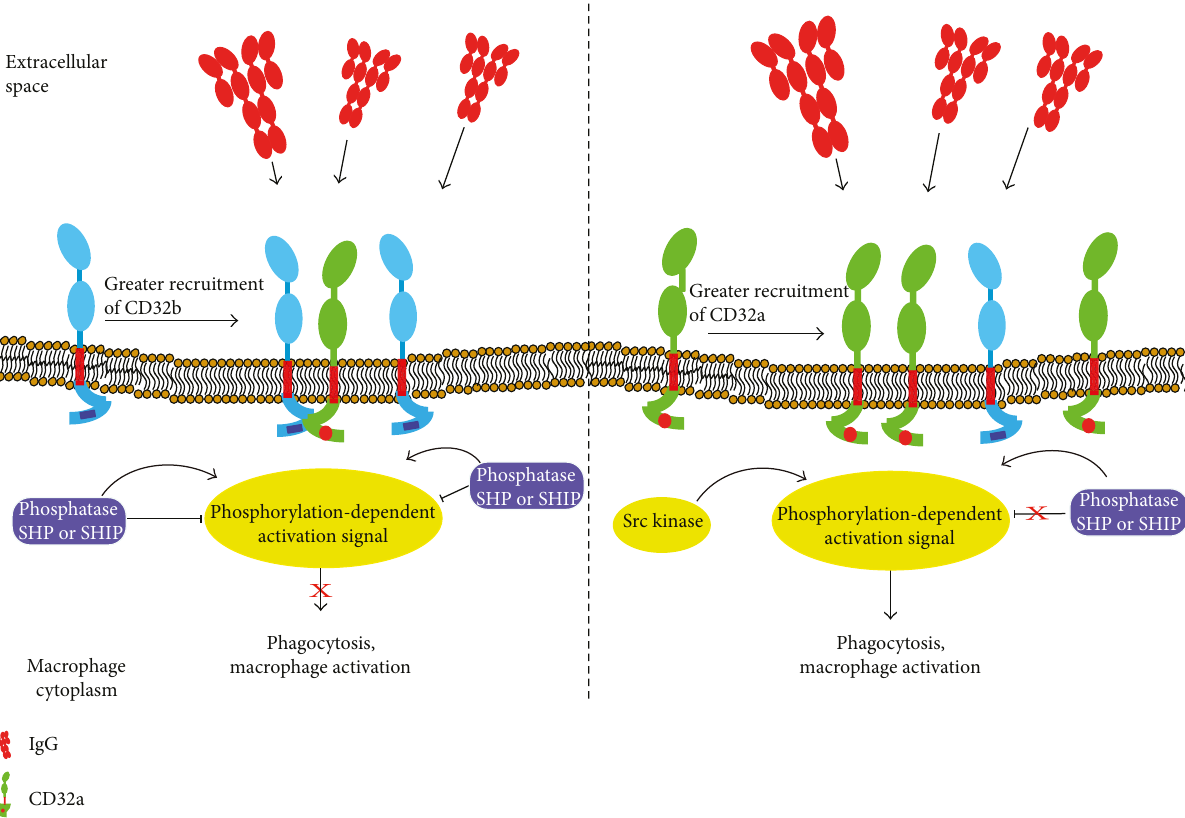
Figure 3: Inhibition mechanism of the Fc γ R receptor (CD32). (a) When CD32b recognizes the Fc fraction of IgG, the phosphatase SHP or SHIP is recruited into the ITIM domains of the intracellular portion of the receptor. Those enzymes inhibit phosphorylation of the ITAM domains or eliminate phosphorylation of the ITAM domains contained in CD32a. This mechanism inhibits the activation of macrophages and the phagocytosis of opsonized pathogens and other elements that are susceptible to recognition by IgG-class antibodies. (b) When the association of CD32a is greater than the frequency of CD32b receptors, phosphatase recruitment is not fostered and, therefore, no inhibition of the activation signals mediated by phosphorylation of the ITAM domains in the intracellular portion of CD32b is produced. As a result, the corresponding internalization mechanisms are